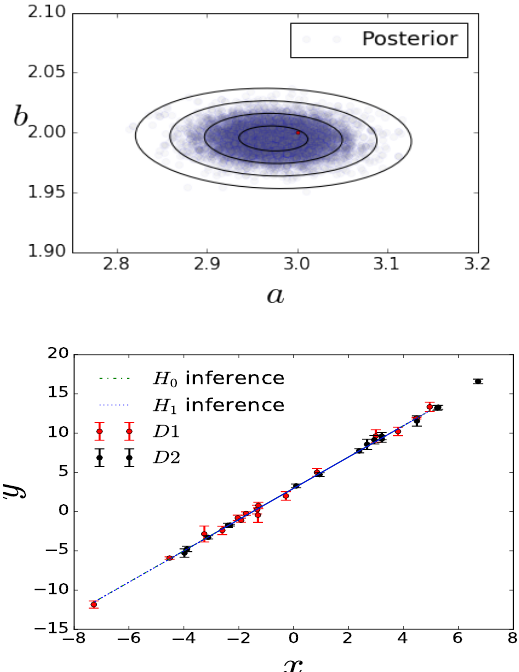
Figure 11. Upper panel: Confidence regions for the parameters in model H 1 . Lower panel: The best straight-lines inferred, along with the